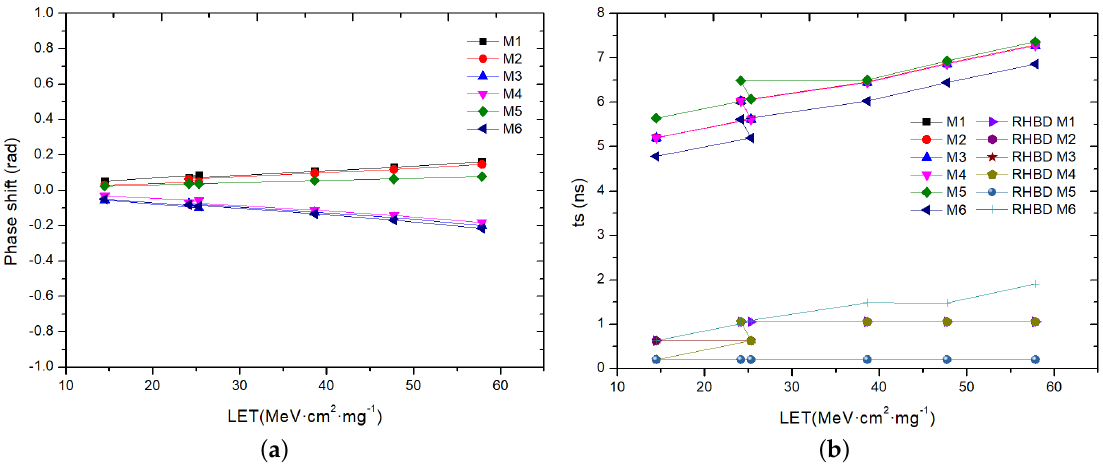
Figure 10. INP output of the RHBD VCO results. ( a ) Phase shift; ( b ) Recovery